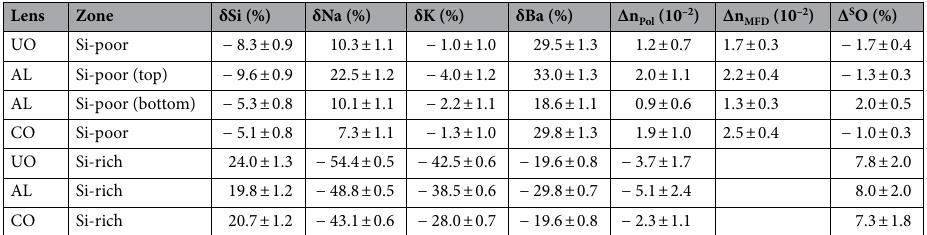
Table 1. Relative enrichment of each element in the modified silicate glass, step refractive index obtained via electronic polarizabilites